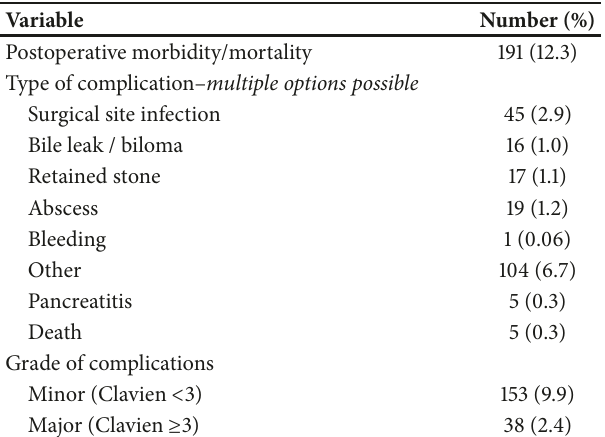
Table 4: Surgical complications and